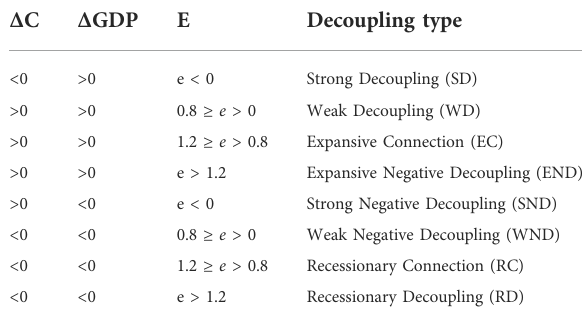
TABLE 2 Decoupling status